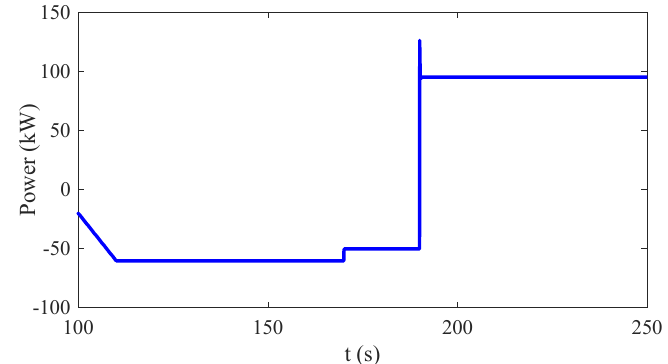
Figure 10. Energy exchanges between the two LESs.